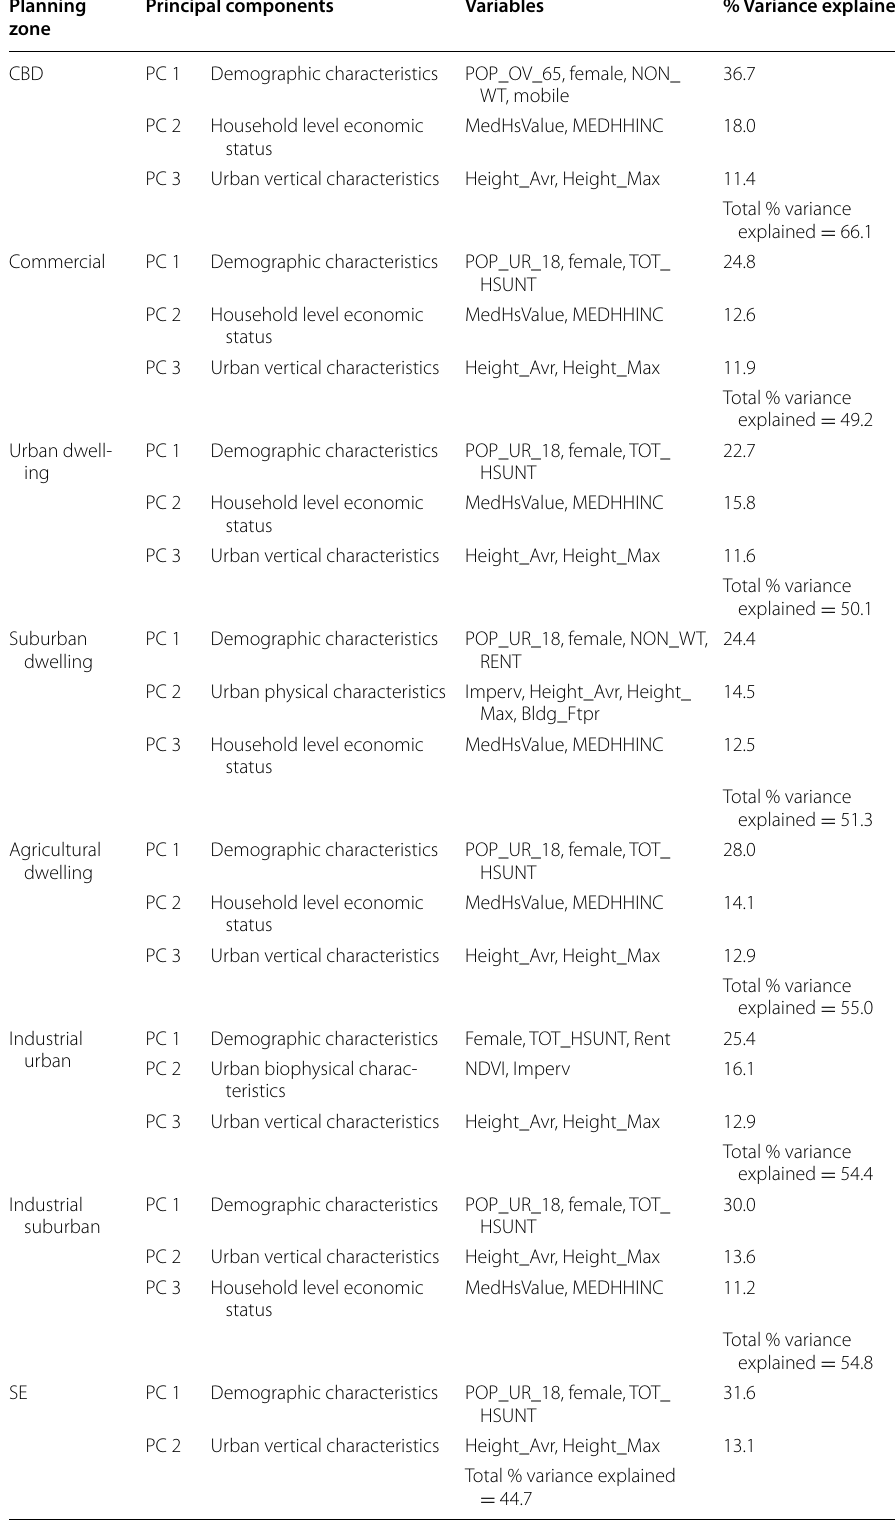
Table 3 Summary of the principal components analysis results by planning zones Planning